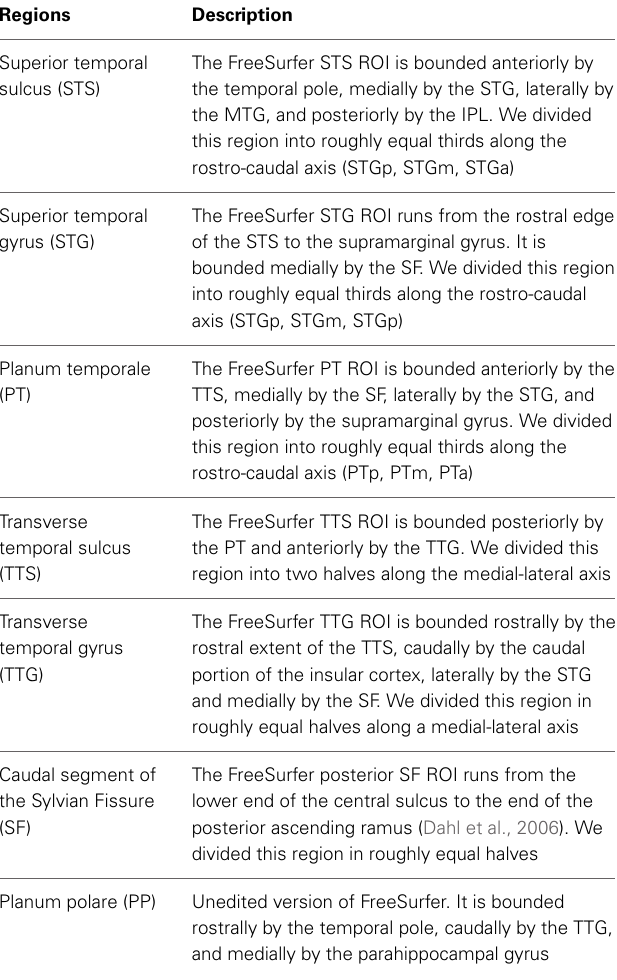
Table 2 | Surface description of the ROI